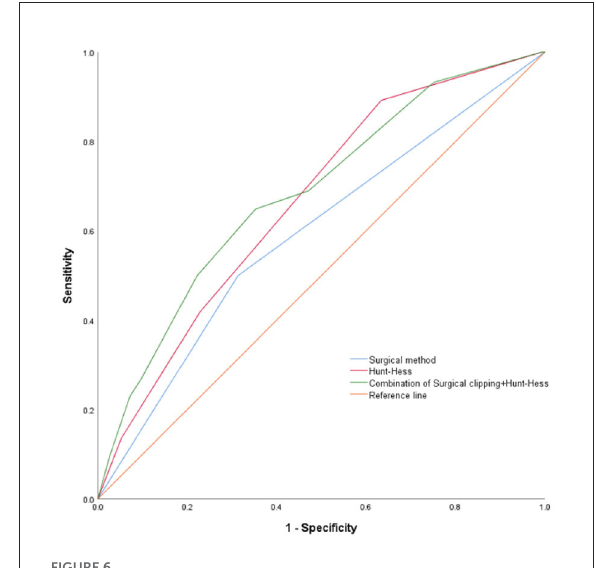
FIGURE6 ROC curve (Based on DCI group, non-DCI group).